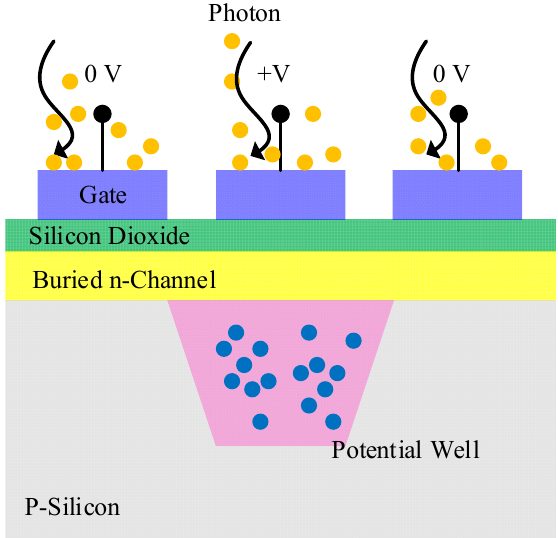
Figure 5. Basic structure of a charge coupled device